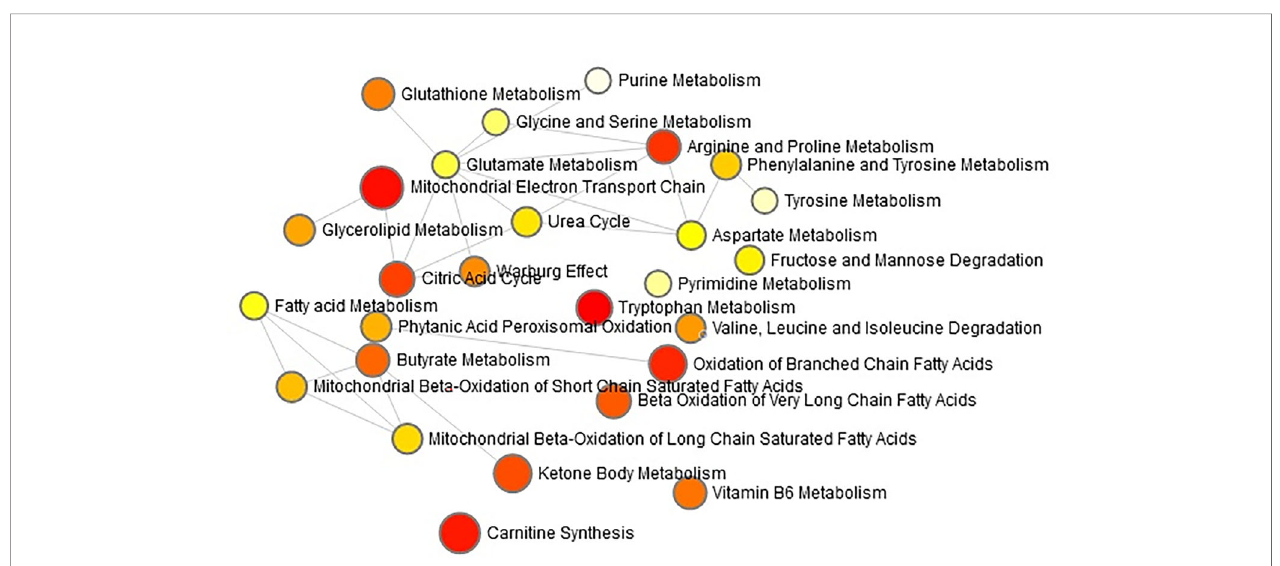
biomarkers between normal mice and APC min/+ mice ( Figure 6 ), and almost all the samples in the two groups were separated. Each cube had an altered area to represent the different relative intensities of biomarkers in each sample.